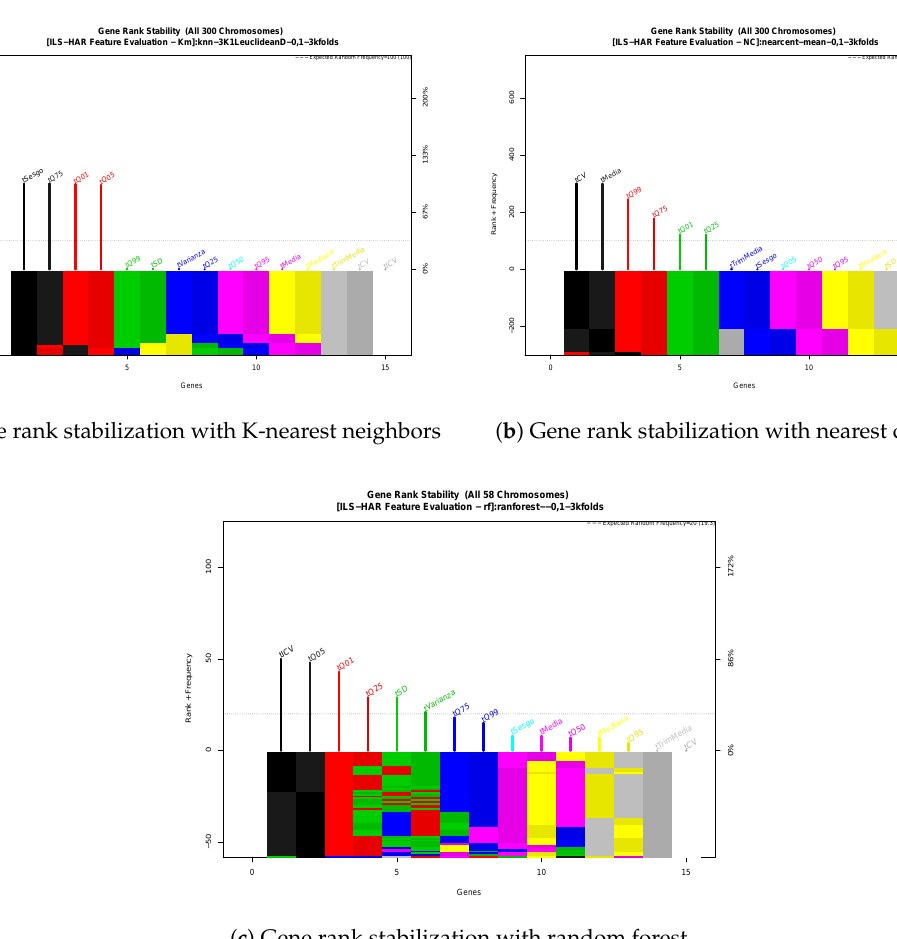
Figure 1. Gene rank stabilization with three different algorithms as function